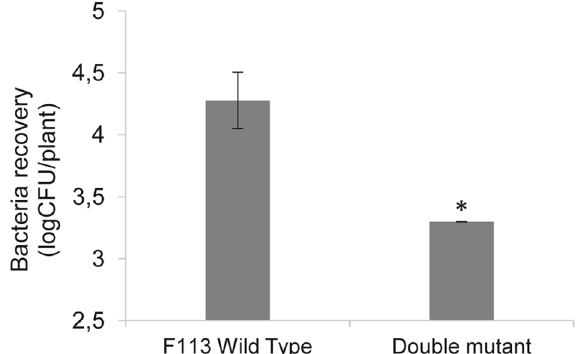
Figure 6. Quantification of recovered cells from rhizosphere colonization. P. fluorescens F113 and the derivative strain TssA1 - /A3 - double mutant were inoculated in the rhizosphere of tomato plants grown in agricultural